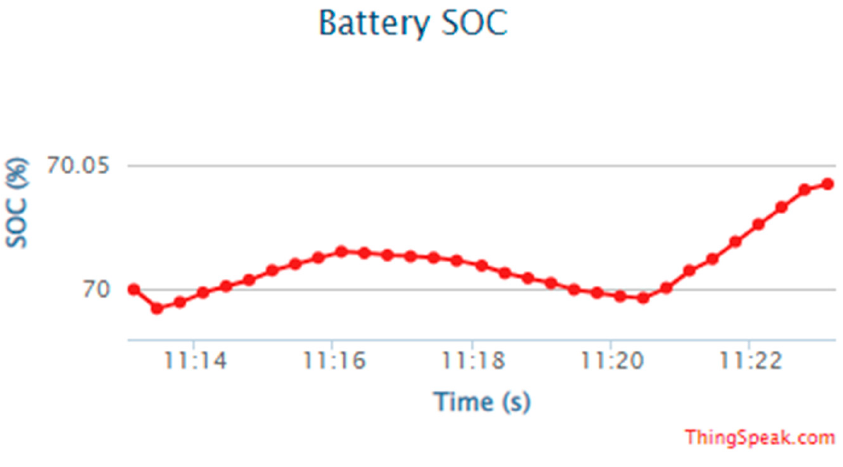
Figure 18. Variation in SOC.